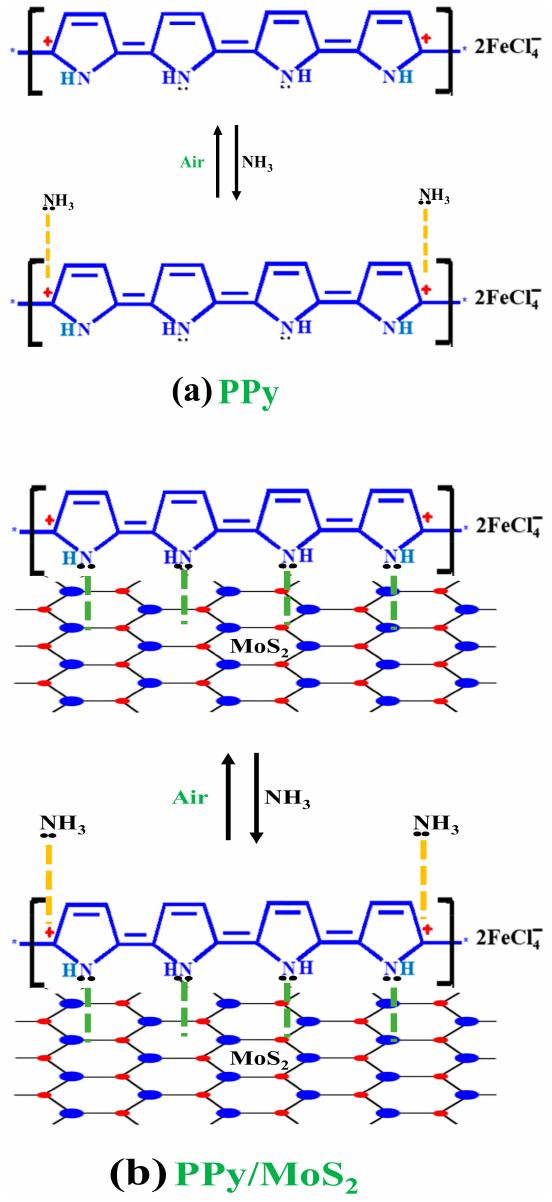
Figure 10. Schematic representation of the plausible NH 3 adsorption-desorption sensing mechanism on ( a ) polypyrrole (PPy) and ( b ) Polypyrrole / MoS 2 (PPy / MoS 2 ) nanocomposites. Table 1. Sensing performance of this work (PPy / MoS 2 ) compared with reported